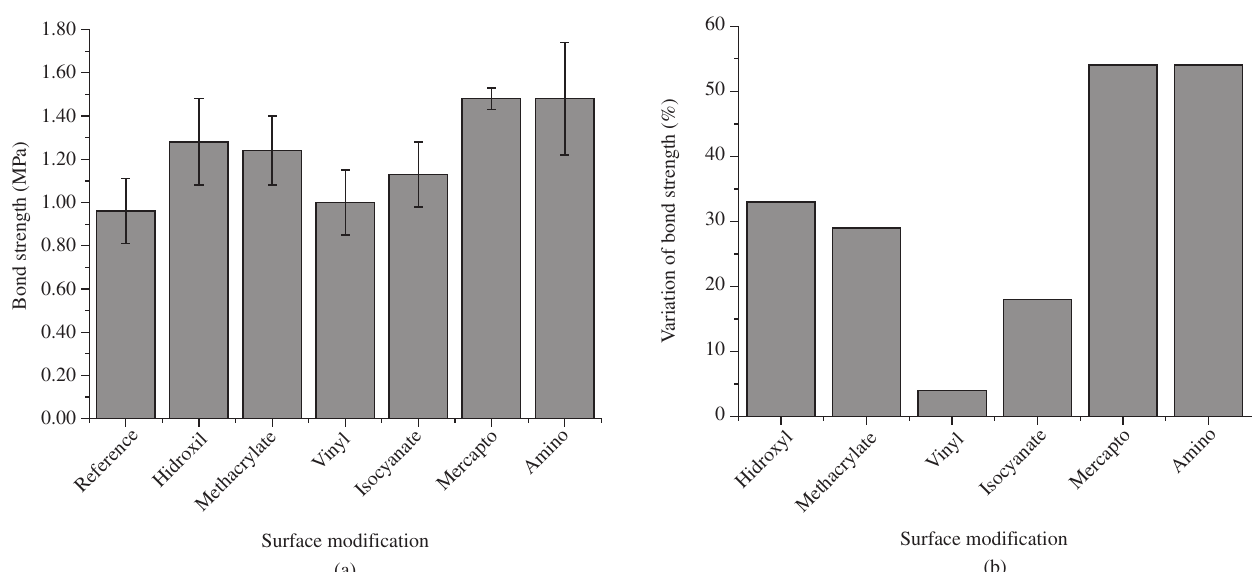
Figure 6. a) Effect of the surface modification on the bond strength of EVA modified Portland cement mortars to glass tiles; and b) Variation of bond strength due to surface modification.